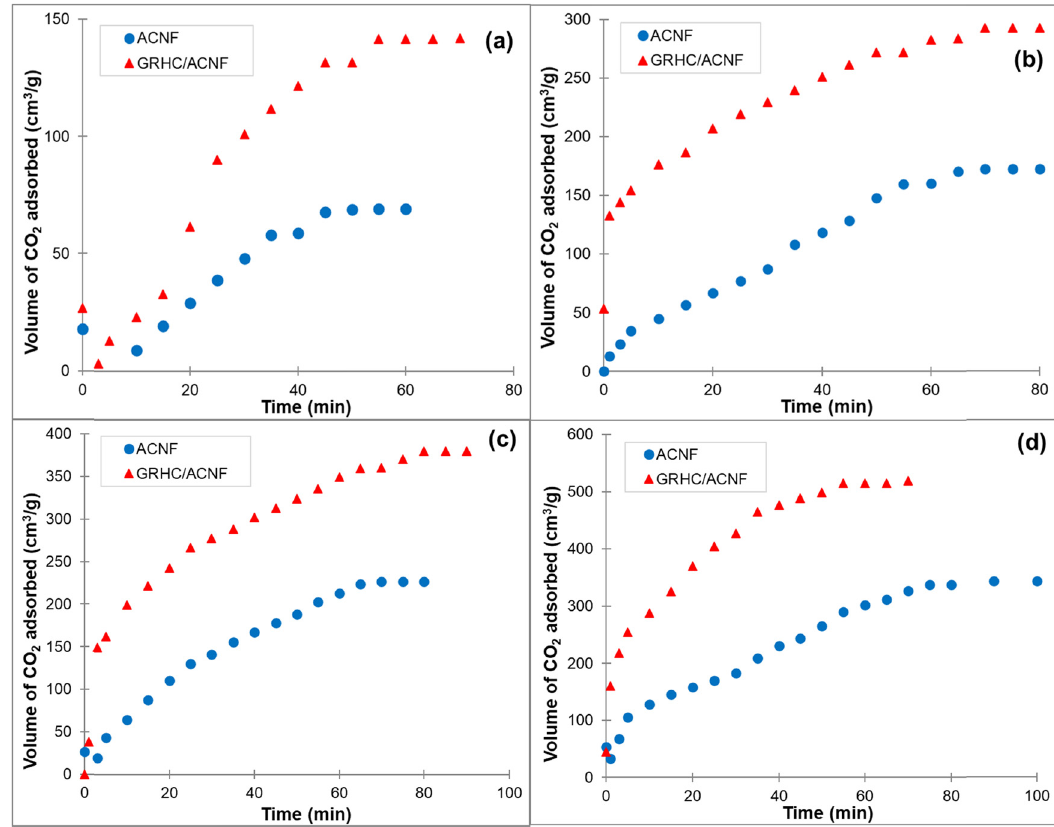
Figure 9: CO 2 adsorption of ACNFs and GRHC/ACNFs at di ff erent adsorption pressures: ( a ) 1 bar; ( b ) 5 bar; ( c ) 10 bar; ( d ) 15 bar at 25°C.